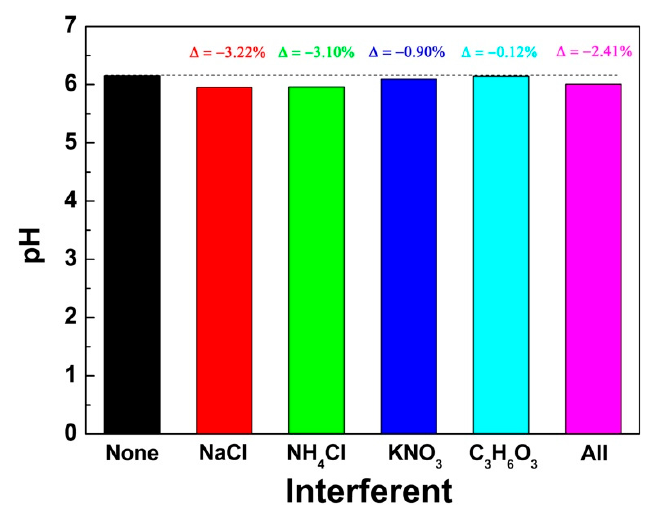
Figure 6. Influence of 25 mM of Na + and Cl − , 0.45 mM of NH 4+ , 1.75 mM of K + and 7.5 mM of lactic acid.